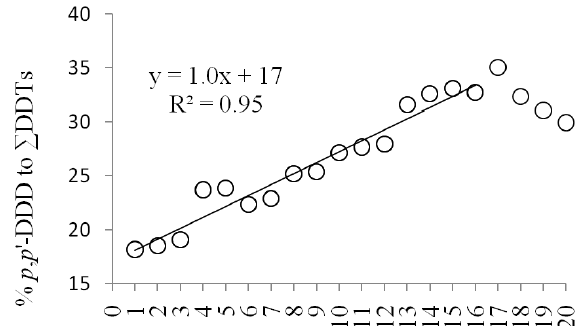
Figure 2. Contribution (%) of p,p’ -DDD to the ∑ DDTs ( p,p’ -DDE + p,p’ -DDD) in the sediment samples (#1 = top sediment). The linear regression was applied in the first 16 samples that had levels above limit of quantification